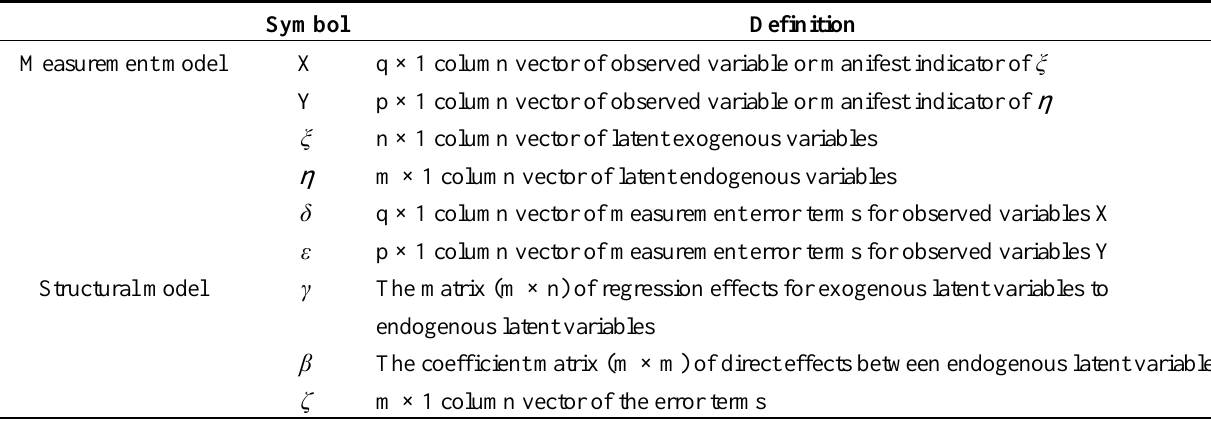
Table 3. Definition of symbols in Figure